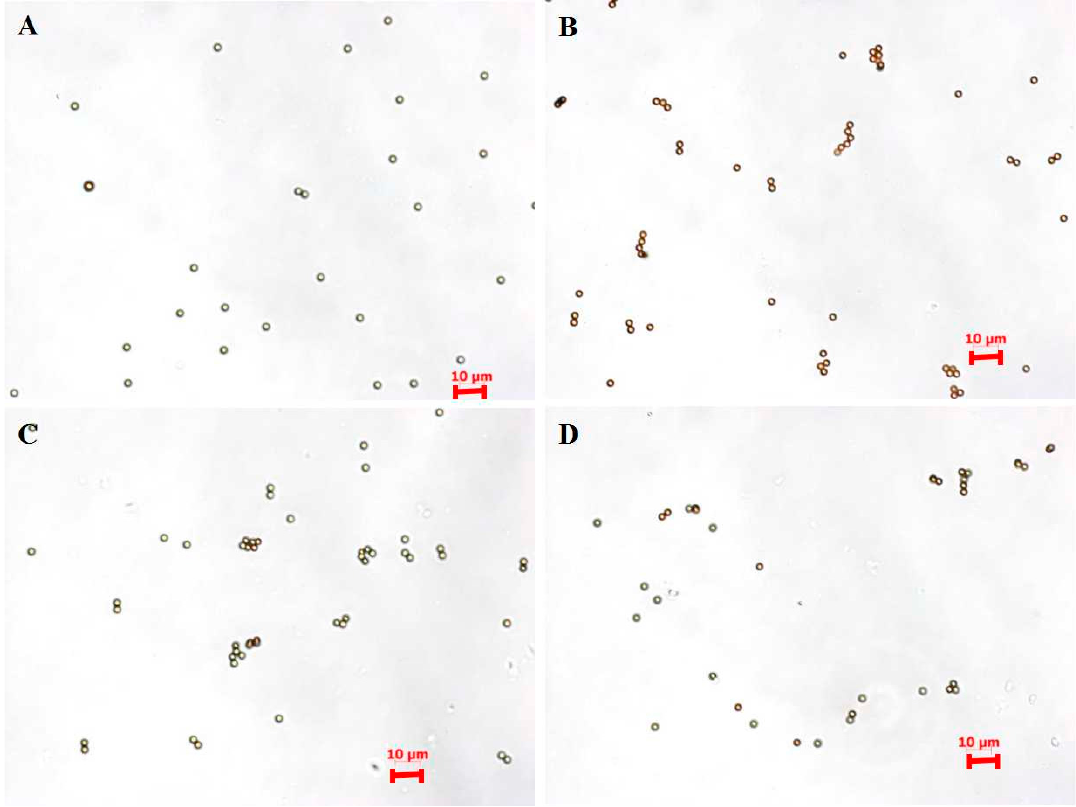
Figure 3. Microscopy images of MBs ( A ) pH6-IMBs ( B ) pH7-IMBs ( C ) and pH8-IMBs ( D ). Table 1. The dispersity of aMBs and IMBs.